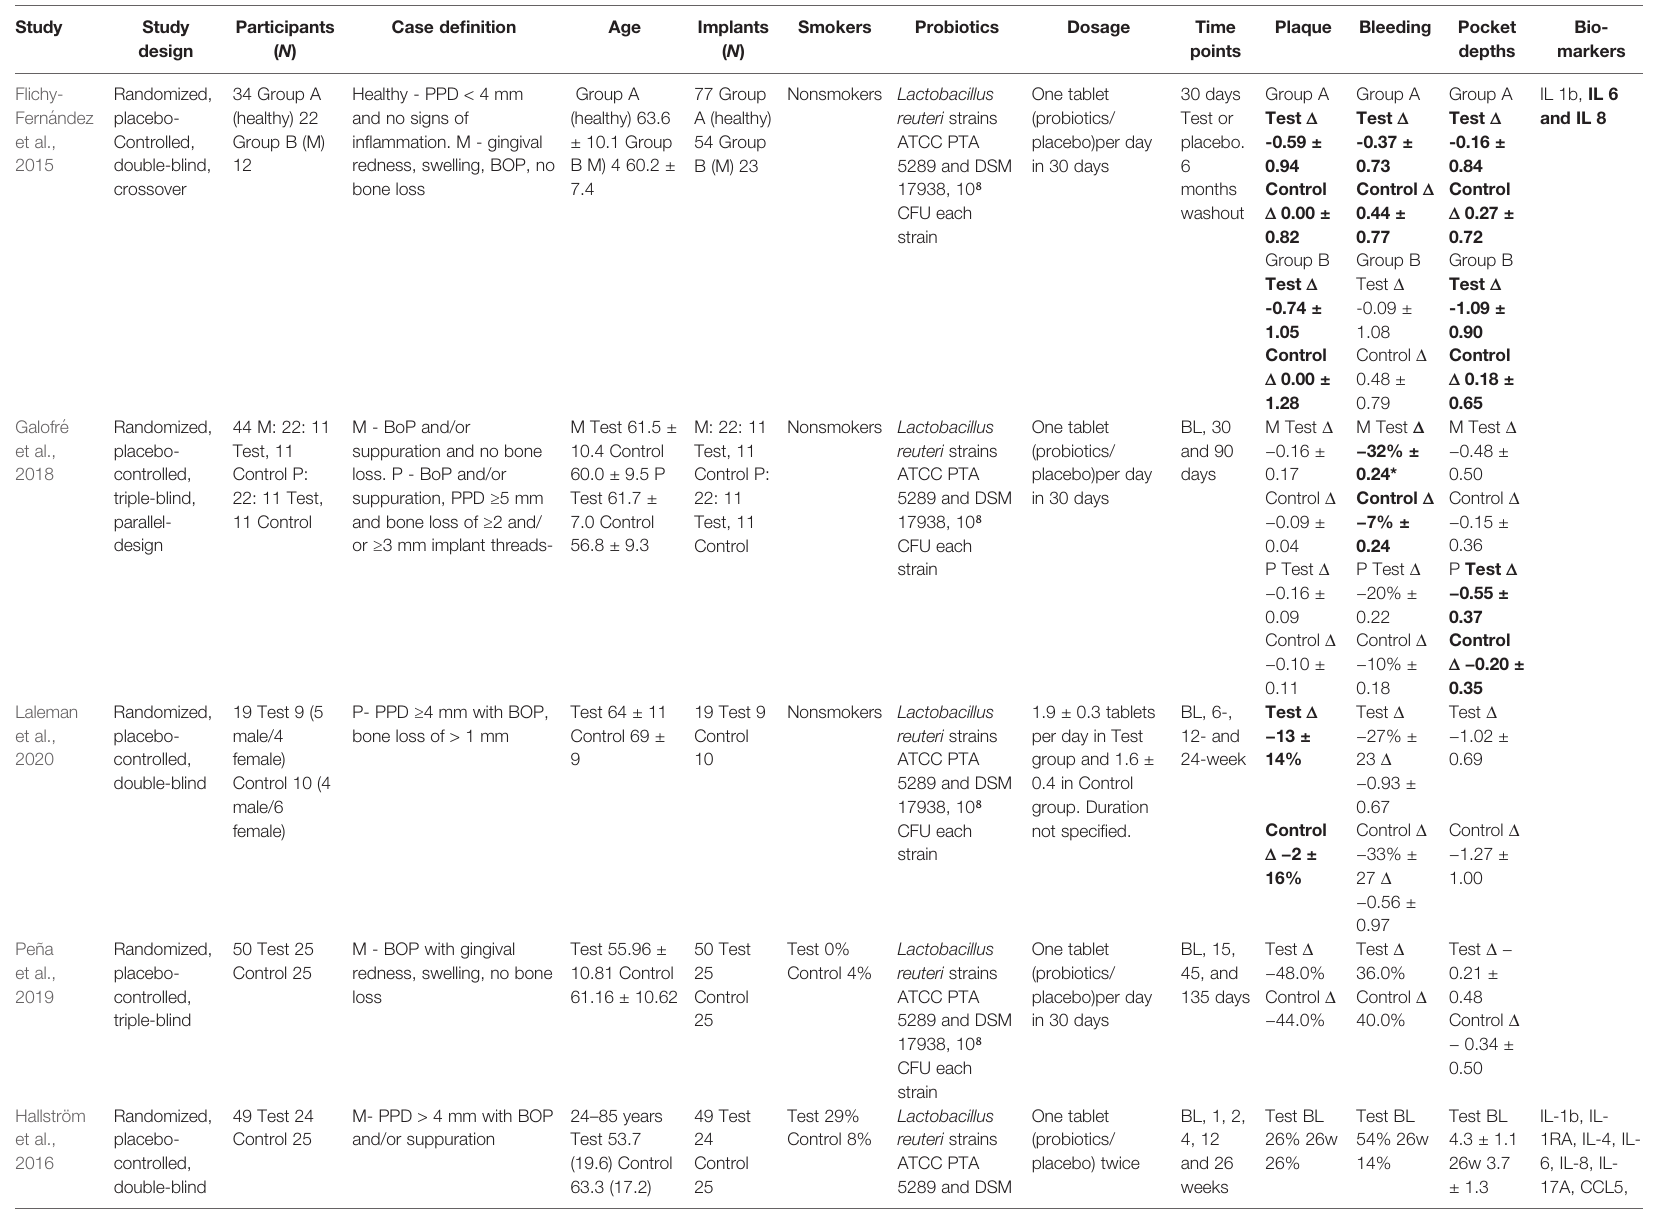
TABLE 2 | Characteristics of the studies included in the analysis of studies on